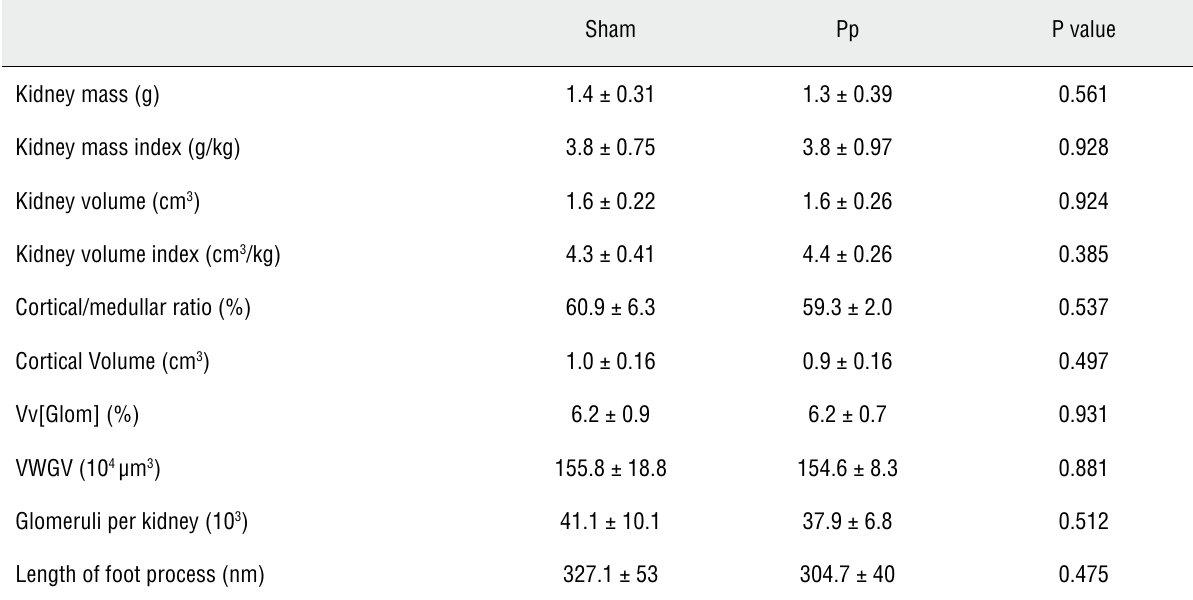
Table 1 - Stereological data of kidneys from rats of groups Sham (n = 7) and Pneumoperitoneum (Pp) (n = 7). The Pp group was submitted to 8 mmHg of Pp for 3 hours, while Sham group was submitted only to anesthesia for the same